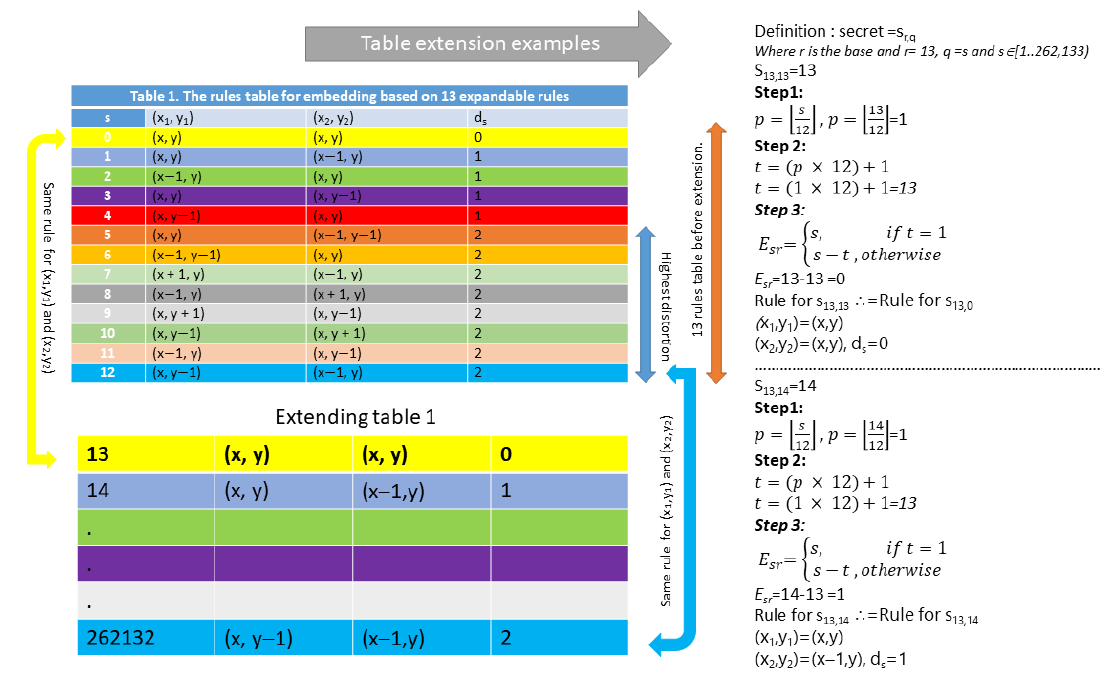
Figure 2. Table 1 extension example.